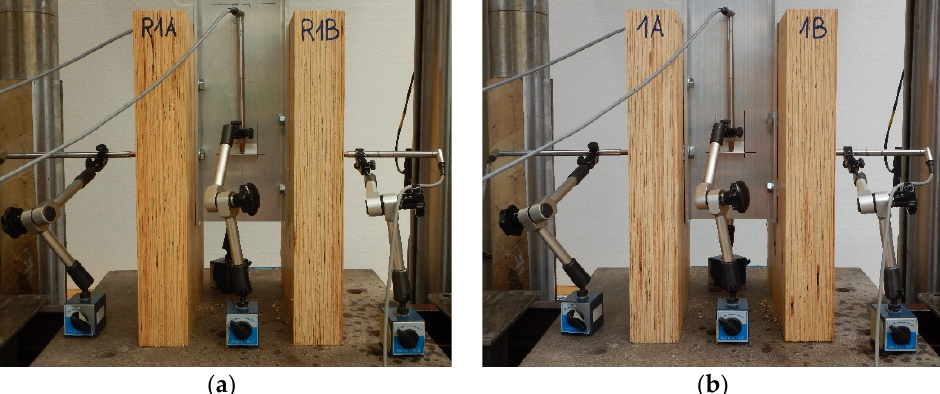
Figure 3. The tested specimens: ( a ) without reinforcing toothed plates; ( b ) with reinforcing toothed plates.